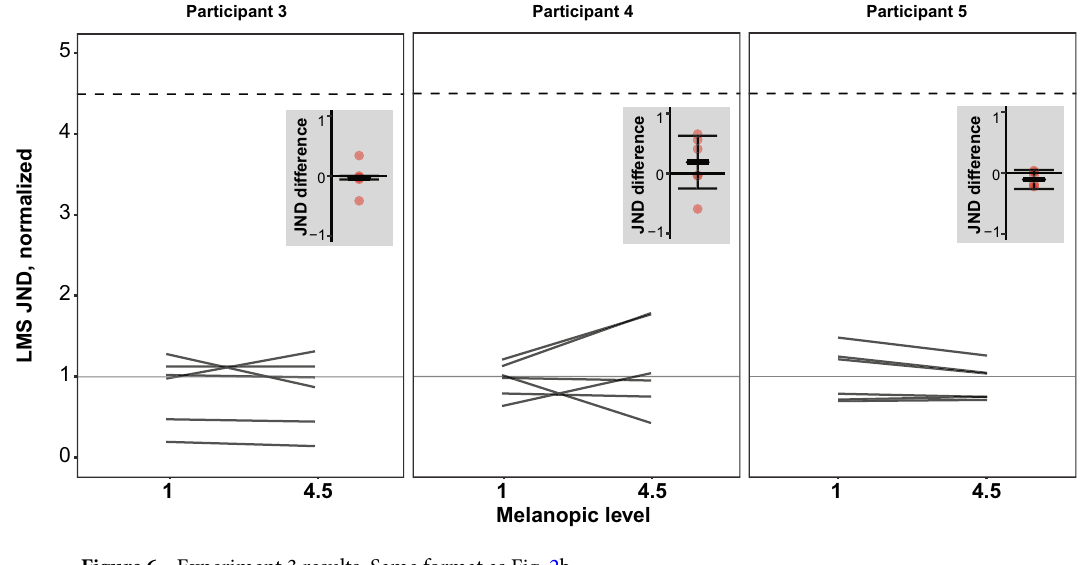
Figure 6. Experiment 3 results. Same format as Fig.